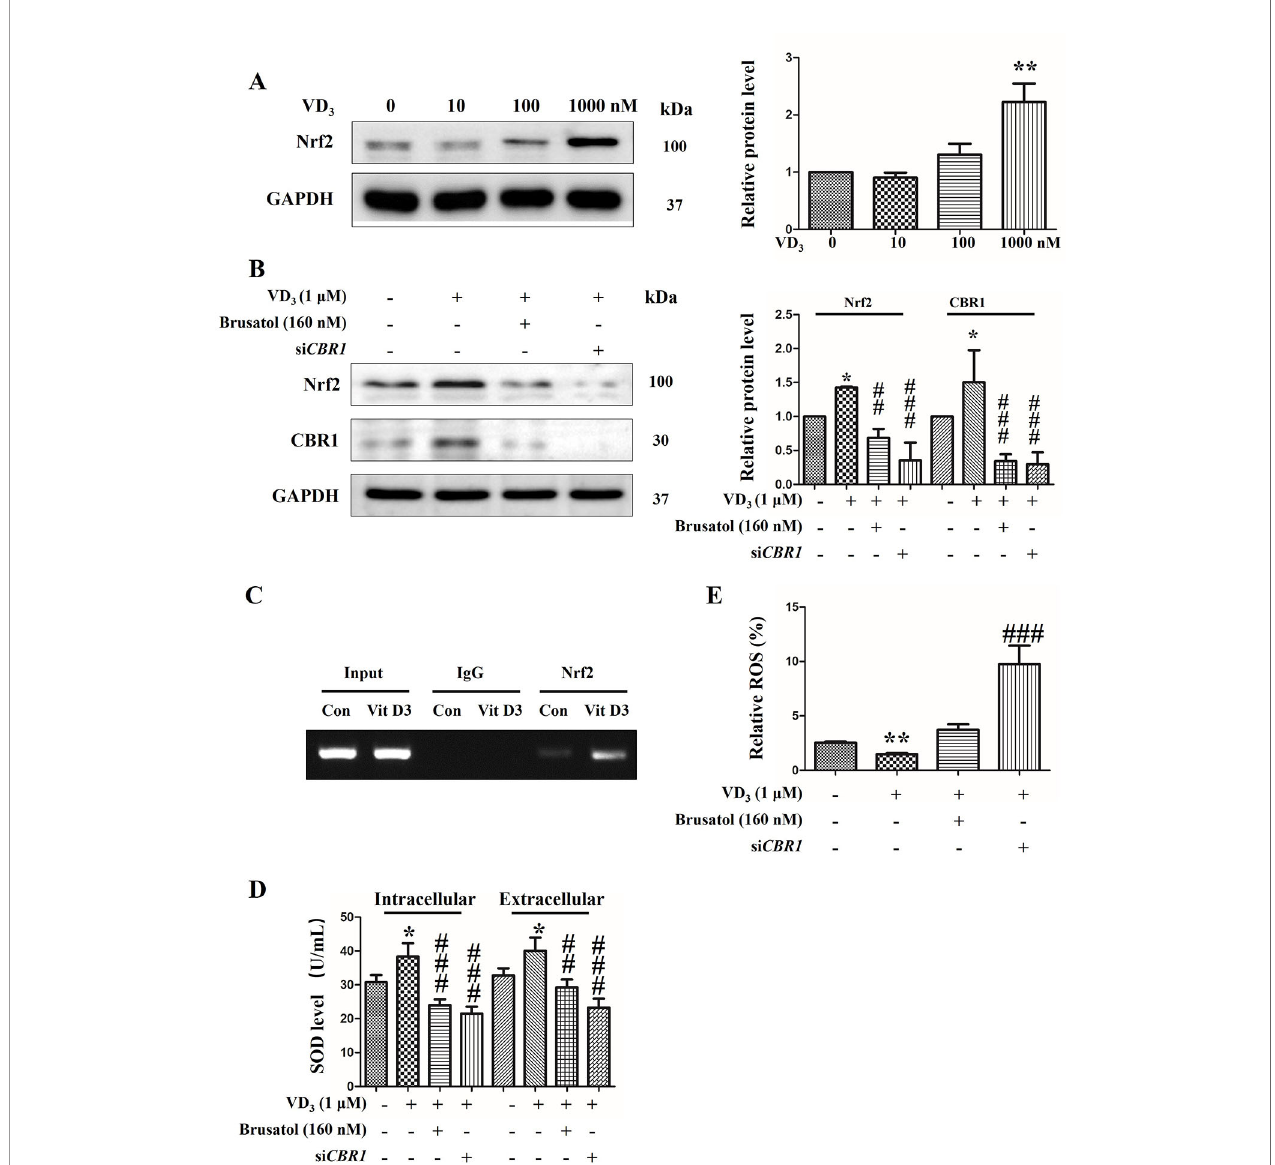
FIGURE 6 | 25-Hydroxyvitamin D activated Nrf2/CBR1 pathway and upregulated the antioxidative activity of BRL cells. (A) BRL cells were exposed to 25- hydroxyvitaminD (VD3) at 0, 10, 100, 1,000 nM for 24 h, and thenNrf2 levels were evaluated by Western blot. (B) BRL cells were exposed to VD3 (1 m M) with or without Brusatol (160 nM) or siCBR1. Next, the level of Nrf2 was determined by Western blotting. (C) CHIP assay was performed using BRL cells treated with1 µM VitD3)/without VitD3 (Con) for 24 h. Normal rabbit IgG and Anti-Nrf2 antibody were used for immunoprecipitation and the CBR1 promoter region was ampli fi ed by PCR. (D, E) BRL cells were treated with VD3 (1 m M) with or without Brusatol (160 nM) or siCBR1. Then, the level of SOD was calculated by SOD assay kit (C) and the ROS accumulation was determined via fl ow cytometry using the CM-H2DCFDA fl uorescence probe (D) . The results are expressed as mean ± SD of three independent determinations. * P < 0.05, ** P < 0.01, vs. control group, untreated group, ## P < 0.01, ### P < 0.001, vs. VD3 (1 m M) treated